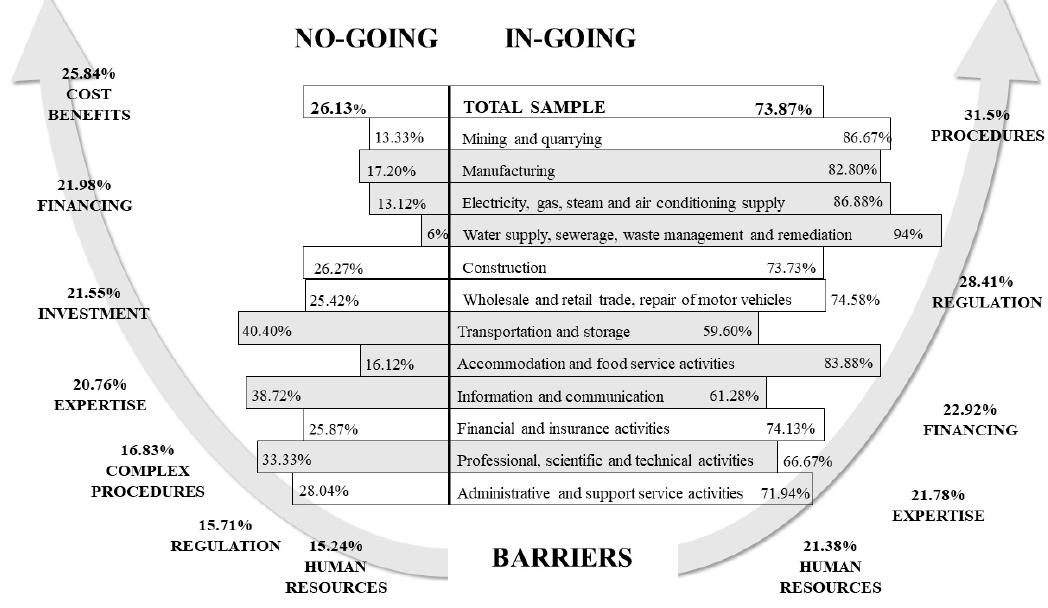
Figure 1. Circular economy implementation and